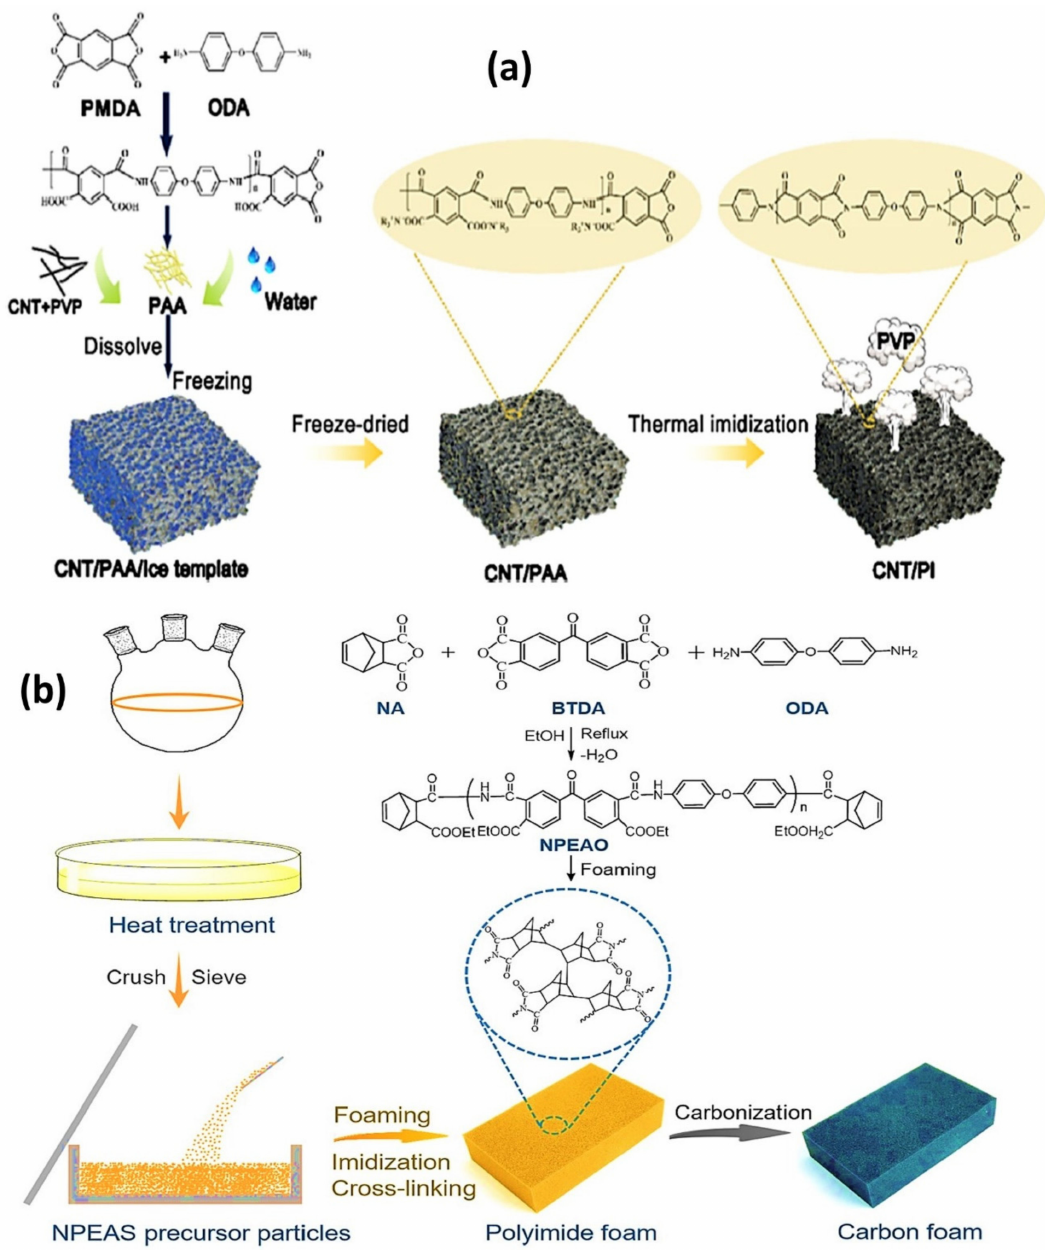
Figure 14. ( a ) Schematic illustrating the preparation of PI/CNT foam. Reproduced with permission from [116]. Copyright 2020, American Chemical Society. ( b ) Schematic demonstration of the fabrica- tion process of carbon foams from PI foam. Reproduced with permission from [117]. Copyright 2020, Elsevier